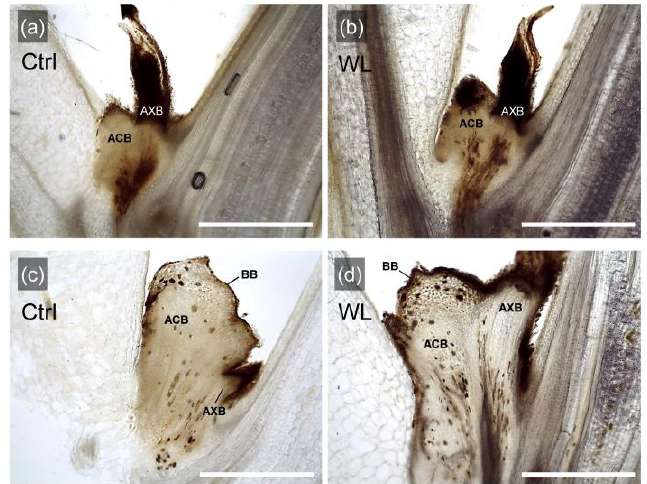
Figure 3. Longitudinal sections of leaf axils grown under control (Ctrl) and waterlogged (WL) soil conditions. Leaf axils without bulbil formation in Ctrl ( a ) and WL ( b ); leaf axils with formed bulbils in Ctrl ( c ) and WL ( d ). AXB, axillary bud; ACB, accessory bud; BB, bulbil. Scale bars, 1 mm.